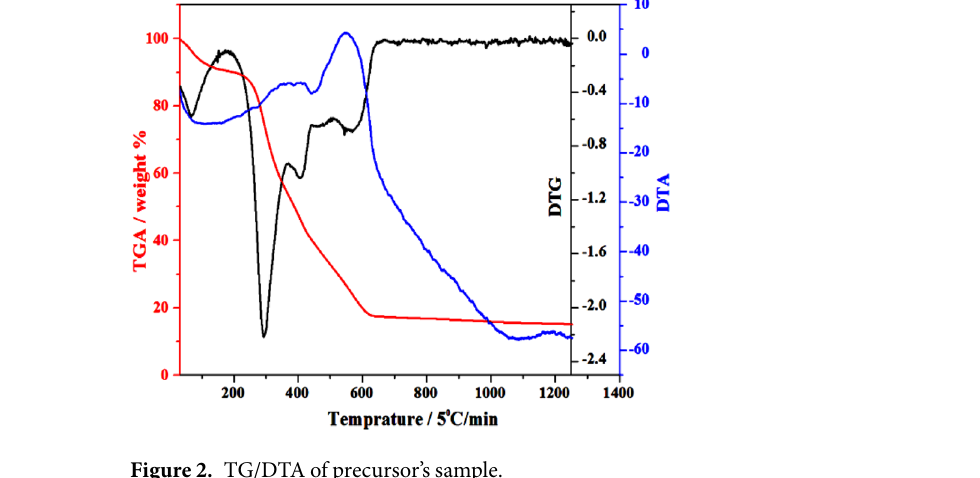
Figure 2. TG/DTA of precursor’s